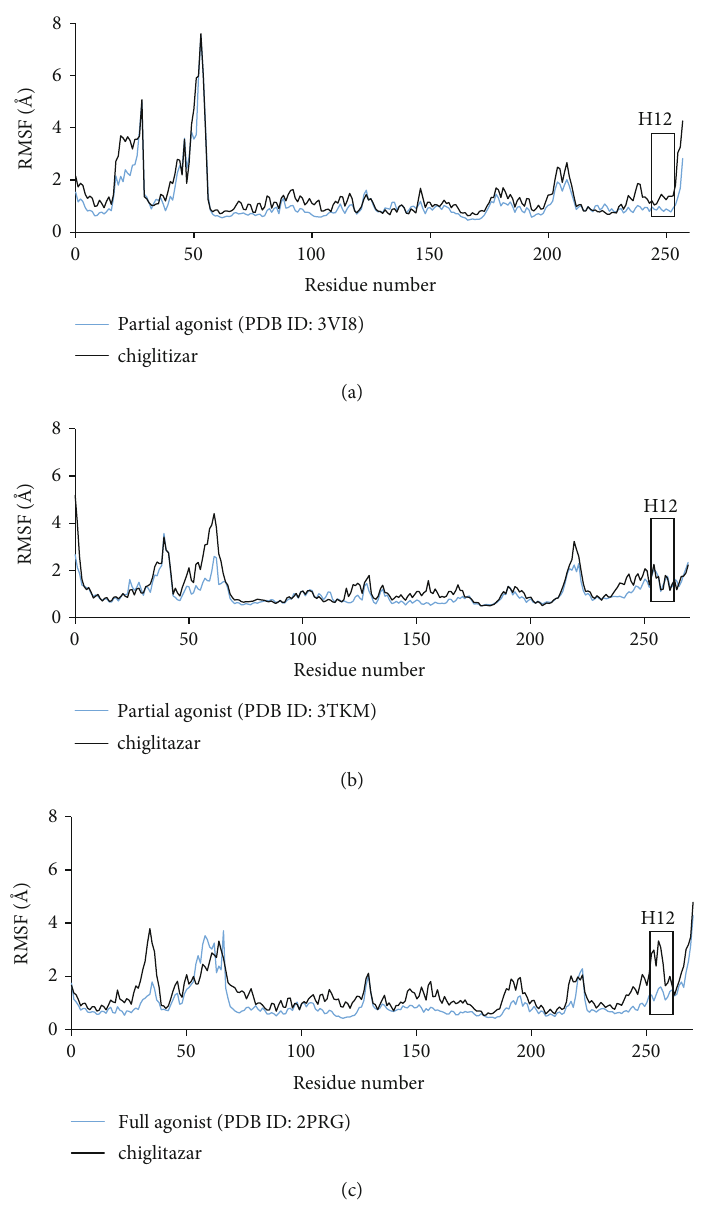
Figure 8: Root mean square fl uctuations of chiglitazar from our MD simulation compared to the crystal ligand systems for PPAR α (a) (PDB ID: 3VI8), PPAR β (b) (PDB ID: 3TKM), and PPAR γ (c) (PDB ID: 2PRG) where the date for the crystal ligands are in blue and chiglitazar ’ s data is in